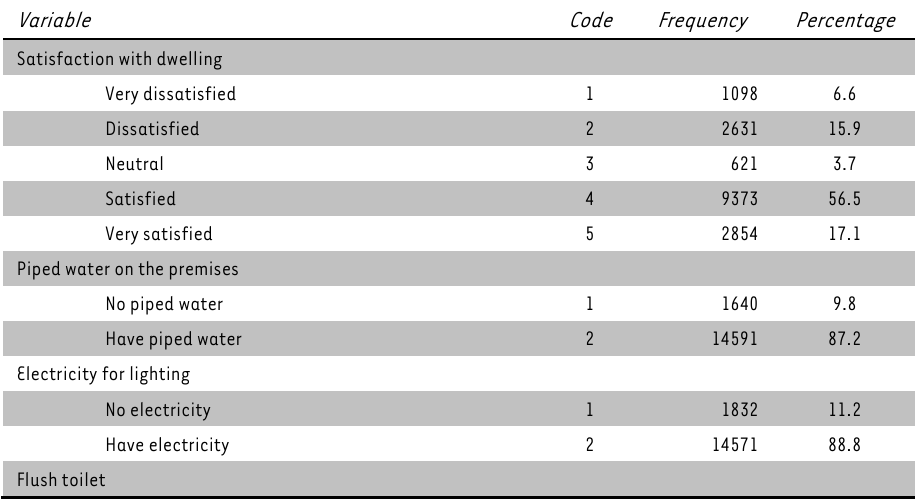
Indicators included in the